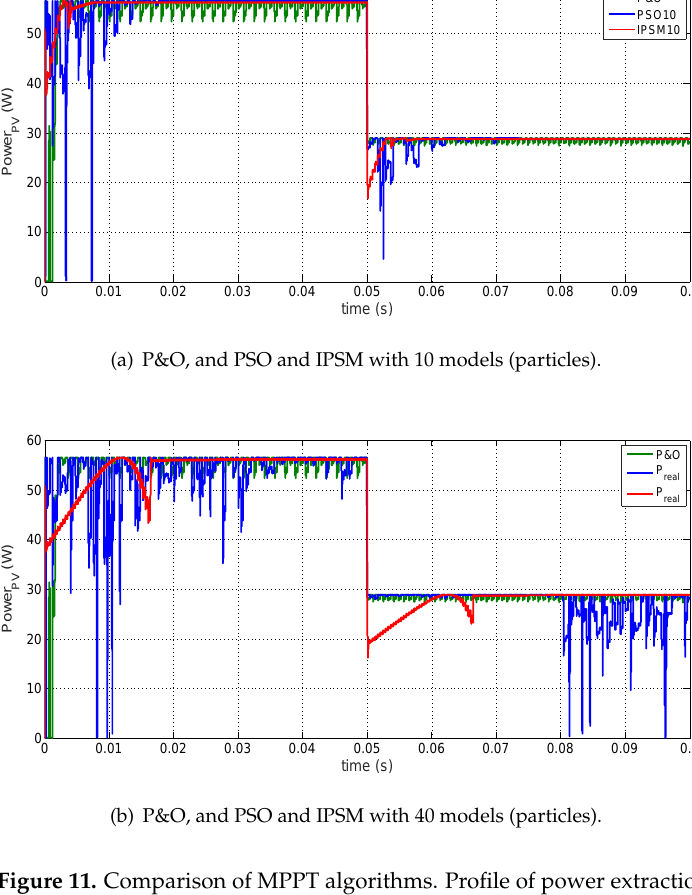
Figure 11. Comparison of MPPT algorithms. Profile of power